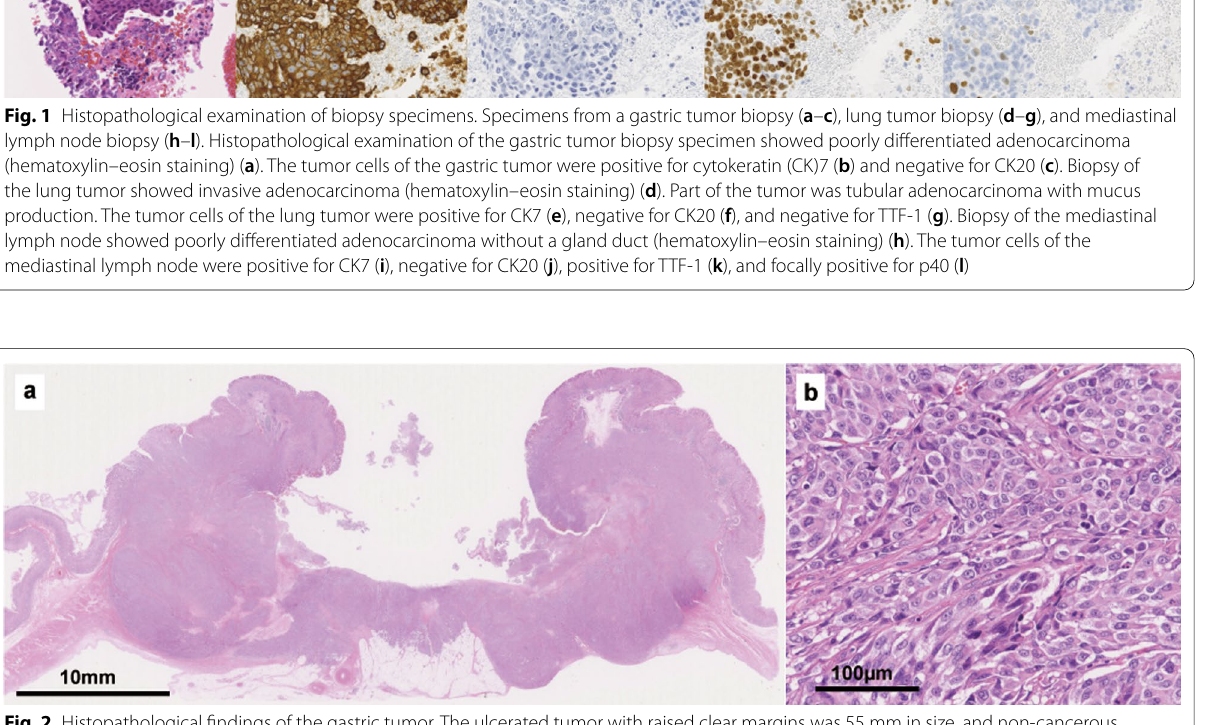
Fig. 2 Histopathological findings of the gastric tumor. The ulcerated tumor with raised clear margins was 55 mm in size, and non-cancerous mucosal tissue covered the raised margin of the tumor ( a ). The tumor consisted of solid type poorly differentiated adenocarcinoma (hematoxylin– eosin staining) ( b